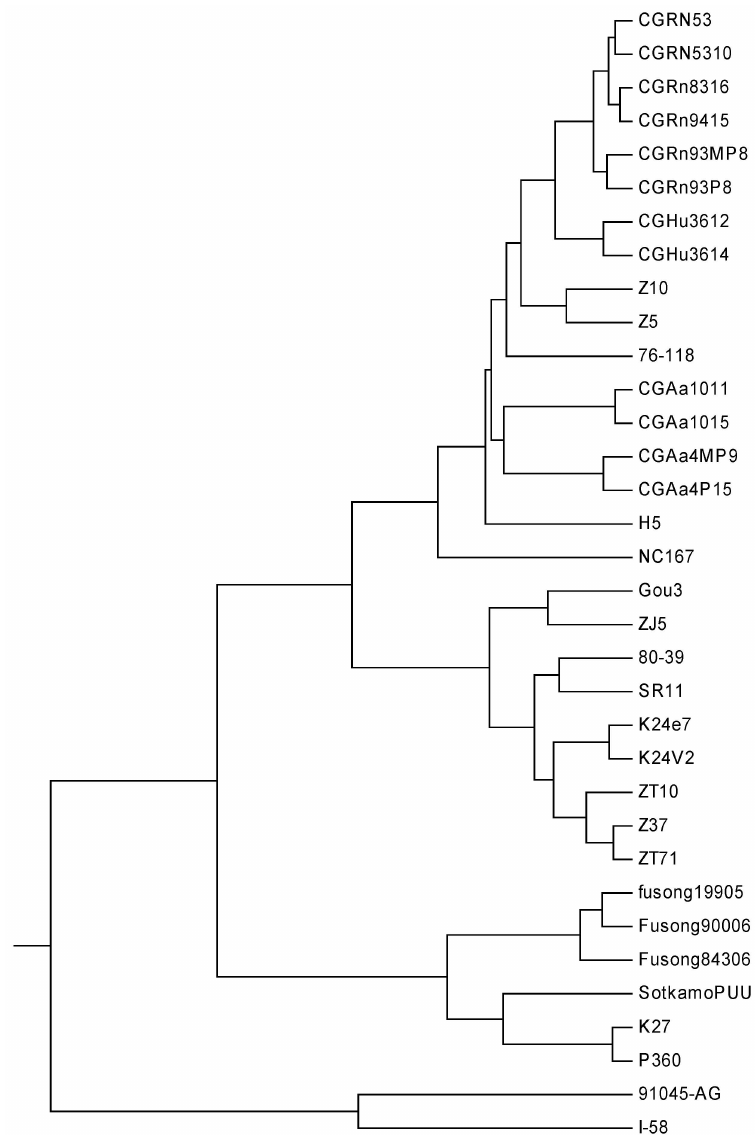
Figure 5. The relationship tree of 34